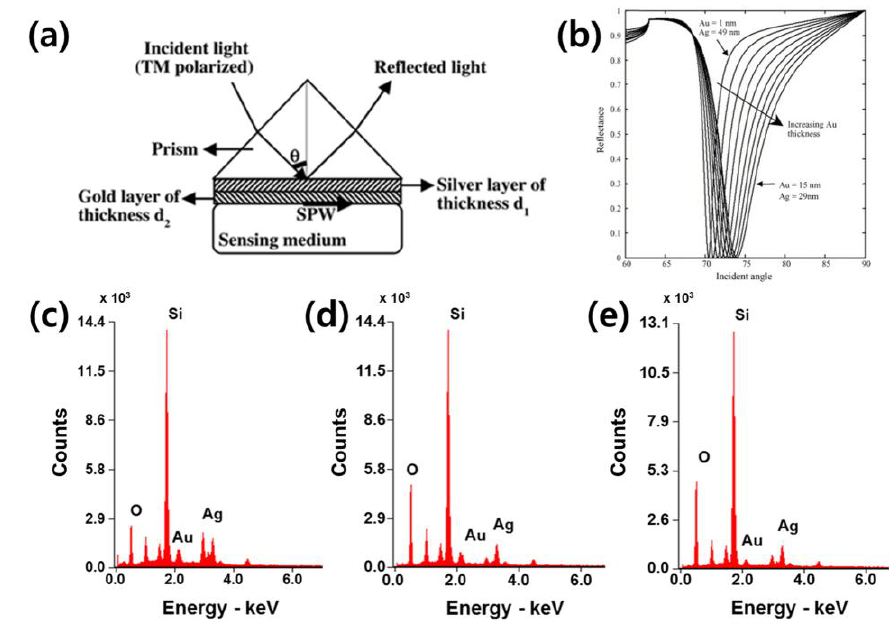
Figure 5. ( a ) A schematic image of Double-metal-layer LSPR sensors is animated. The two-different thicknesses of double-metal-layer metallic layers are presented between prism and sensing medium (reproduced from [122] with permission from Elsevier); ( b ) The thicker gold–thinner silver film coated substrate shows a broader FWHM of resonance dip, thereby it lower sensitivity (reproduced from [123] with permission from Elsevier). It would be better to choose thicker silver film with thin gold film for enhancing the sensitivity. The EDS spectra of the double-metal-complex substrates are shown when the deposition rates are ( c ) 1:1, ( d ) 1:2 and ( e )